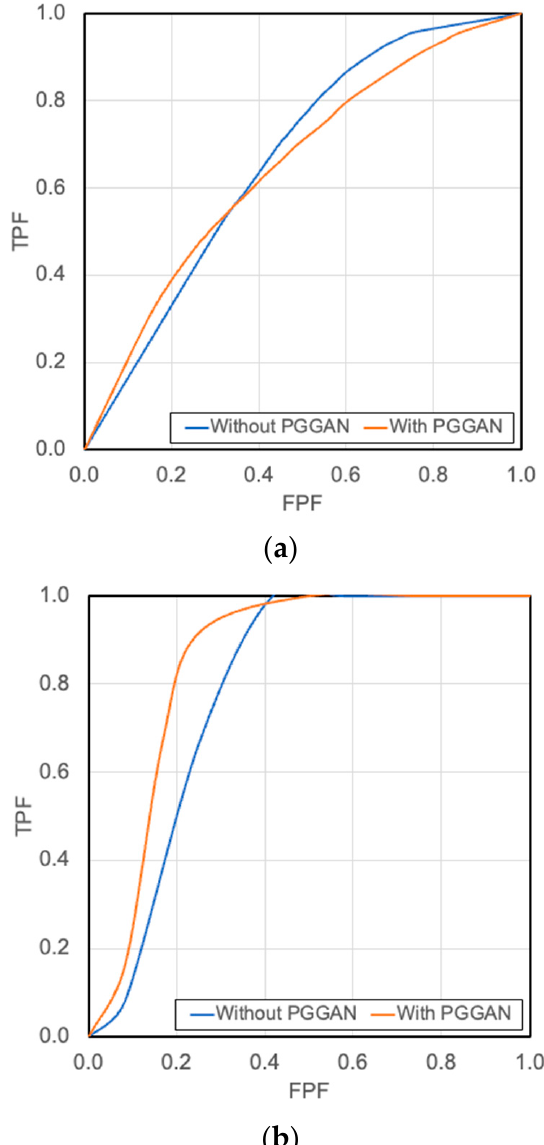
Figure 9. Receiver operating characteristic (ROC) curves: ( a ) Image-based classification; ( b ) Case- based classification.